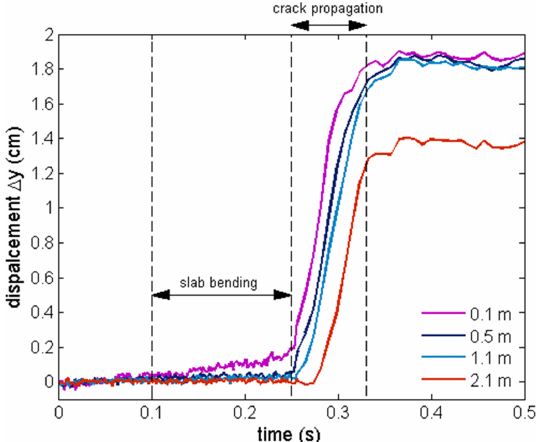
Figure 3. Temporal evolution of the measured vertical displacement (cid:49)y for a slab density of ρ = 240kgm − 3 obtained through PTV analysis of the marker’s displacement from a field experiment. The different curves correspond to different horizontal positions in the slab, from the left-end ( x = 0 . 1m) to the right-end ( x = 2 .